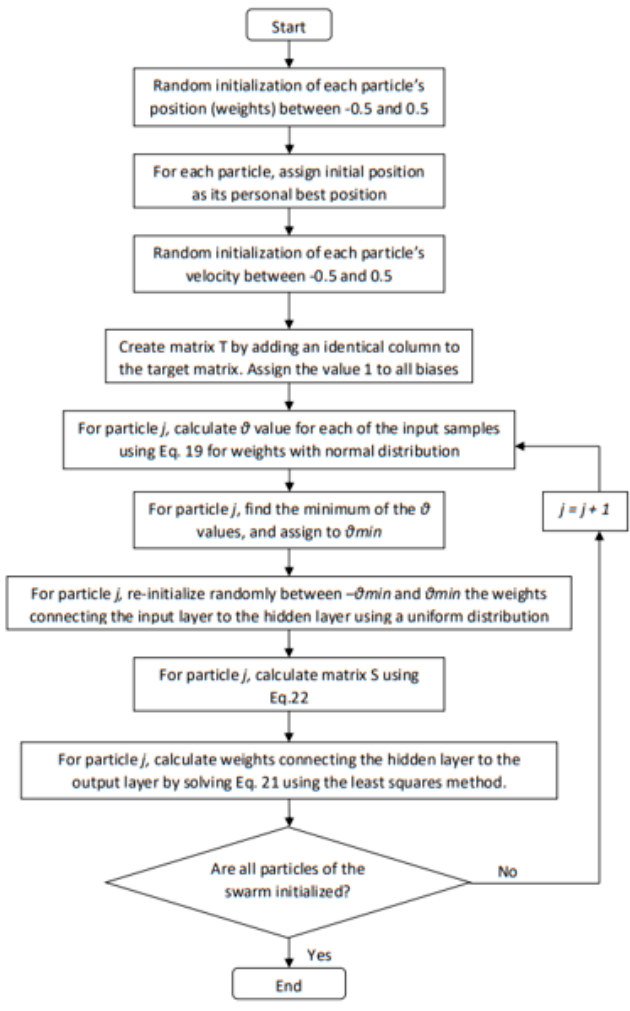
Figure 6. Flow chart of the Yam-Chow initialization process. The magnitude of the weights for a pattern p is defined by: